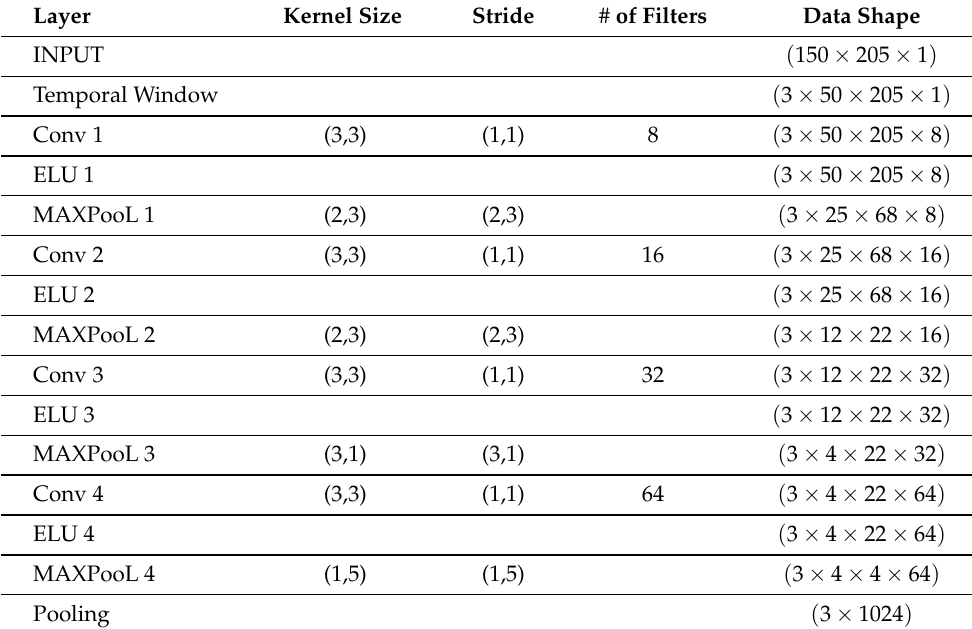
Table 1. Window Encoder Specifications for Temporal Window Attention. Kernel Size # of